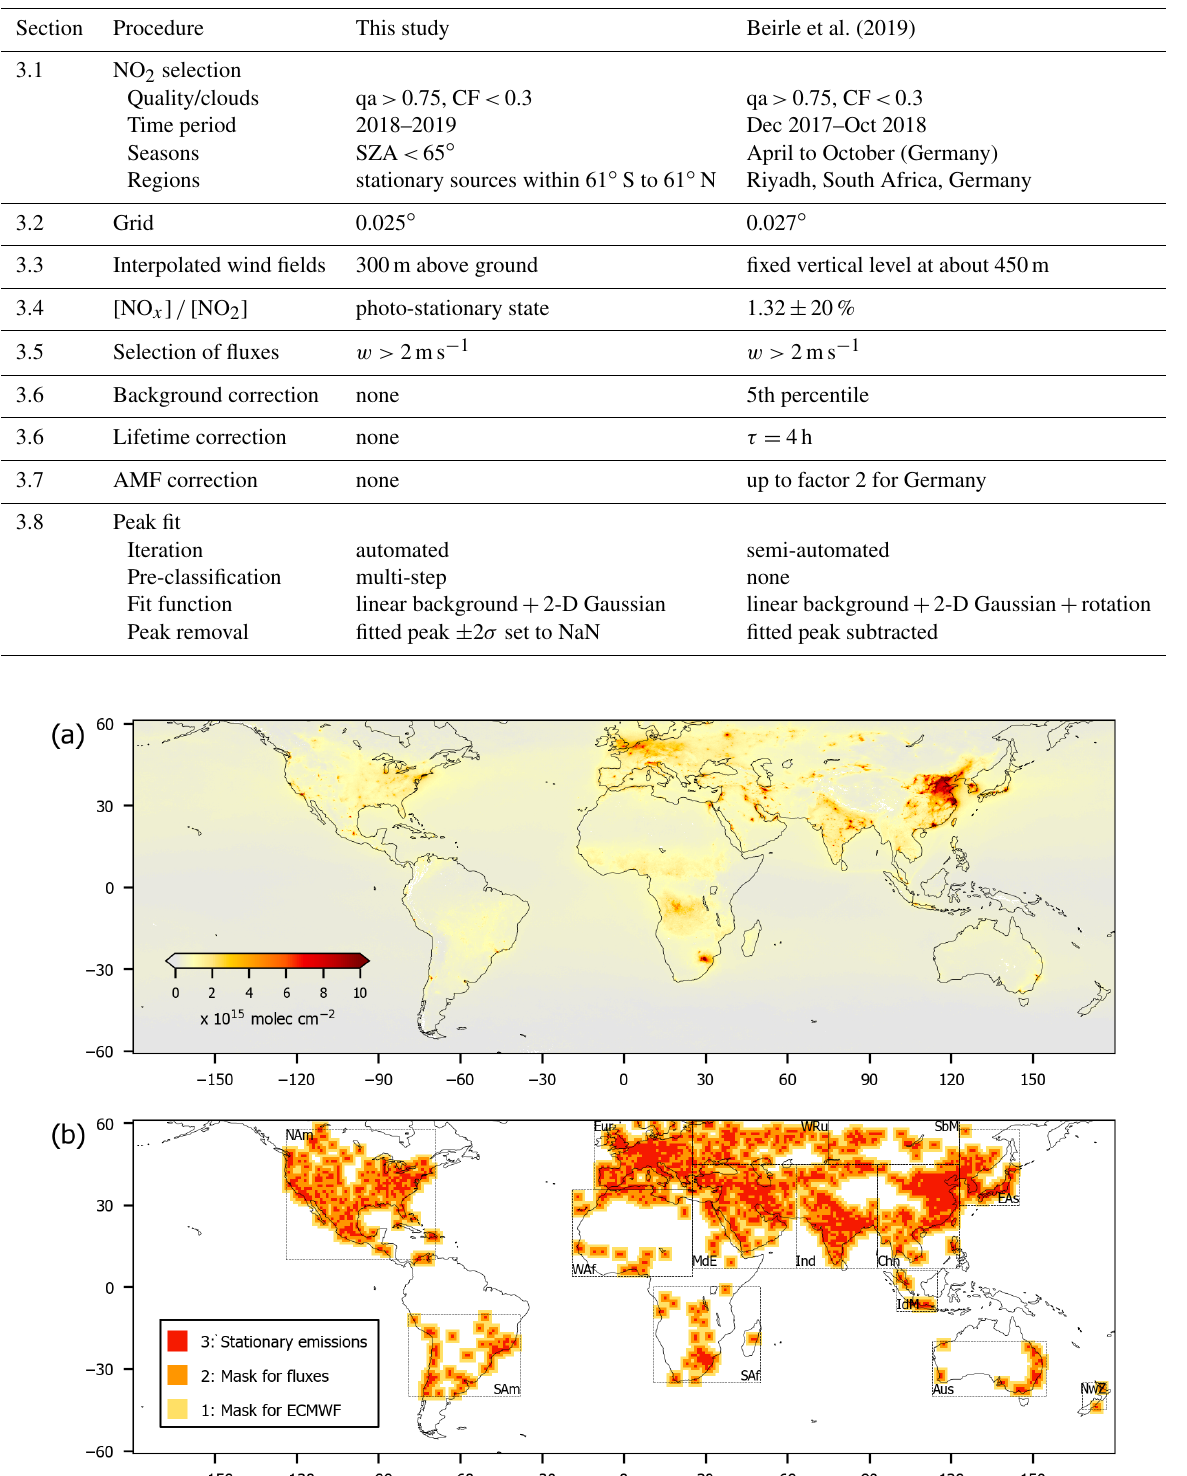
Earth Syst. Sci. Data, 13, 2995–3012,